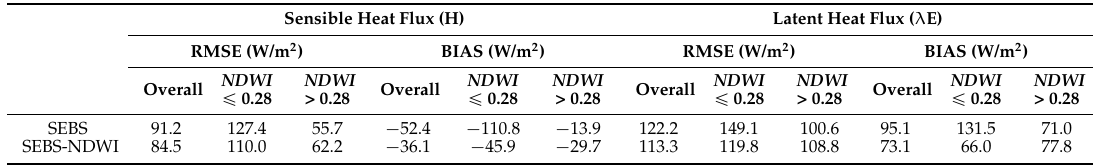
Table 2. Error evaluations of the estimated sensible heat flux and latent heat flux from the original SEBS and the NDWI-integrated SEBS at the Yingke station